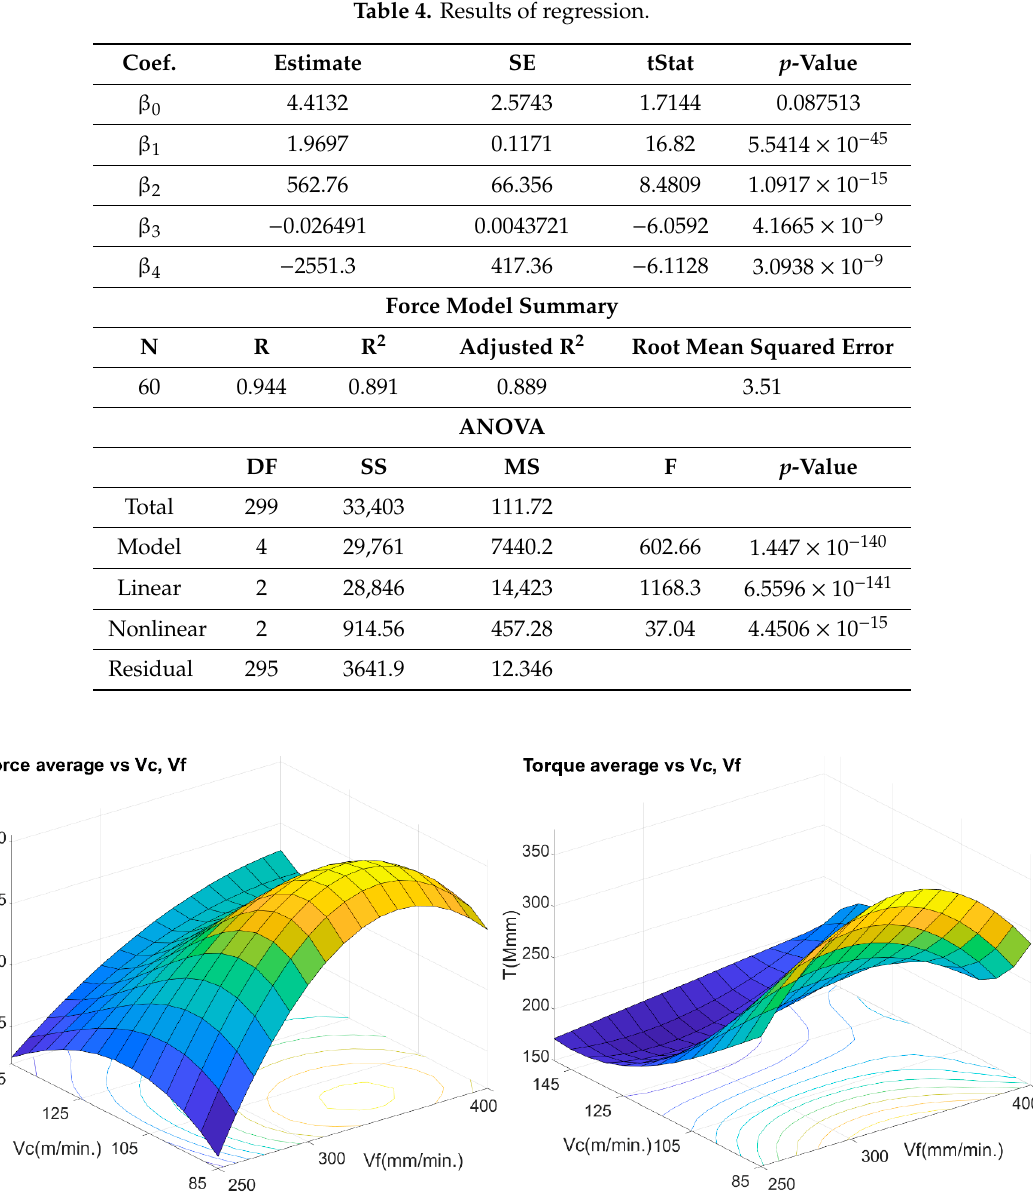
Table 4. Results of regression.